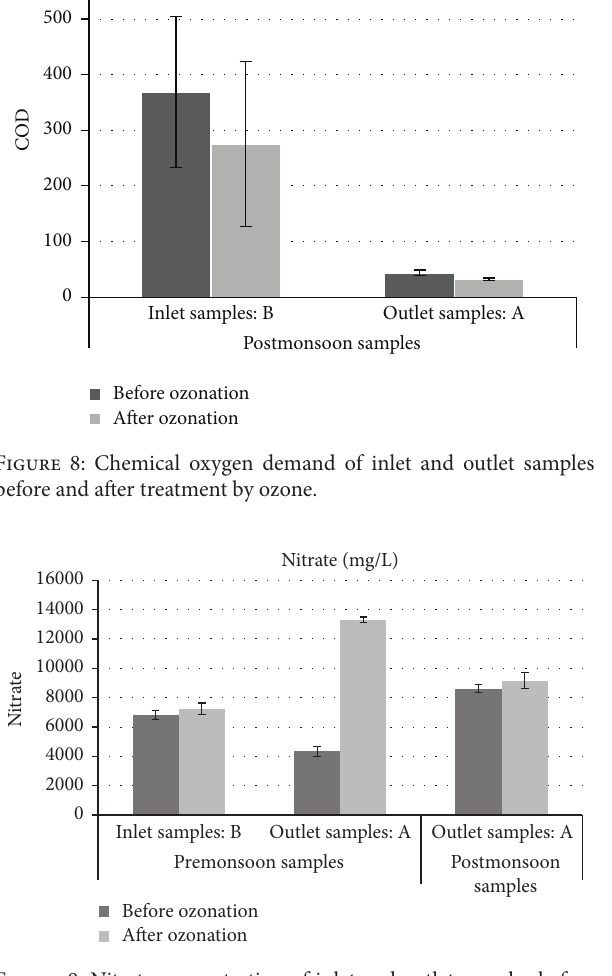
Figure 9: Nitrate concentration of inlet and outlet samples before and after treatment by ozone.